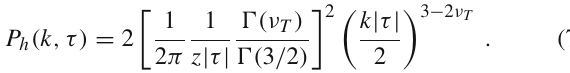
Fig. 1 Parametric plot of n s vs r for 0 . 01 ≤ R h n (cid:2) 0 .